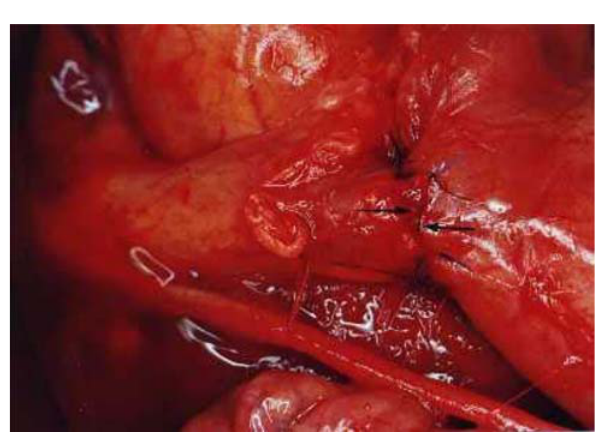
FIGURA 14 - Desenho mostra corte longitudinal da anastomose do Grupo II (Aspecto interno).